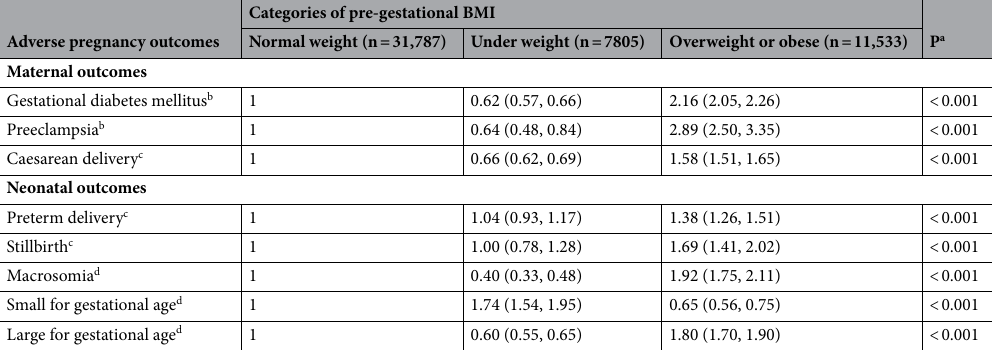
P a Normal weight (n = 31,787) Under weight (n = 7805) Overweight or obese (n = 11,533)